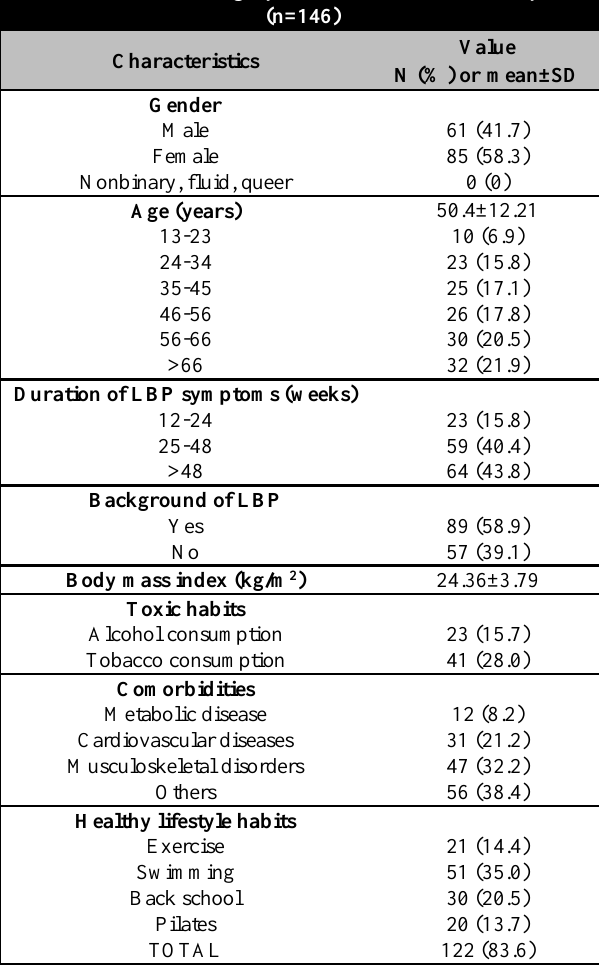
Table 1: Sociodemographics characteristics of sample